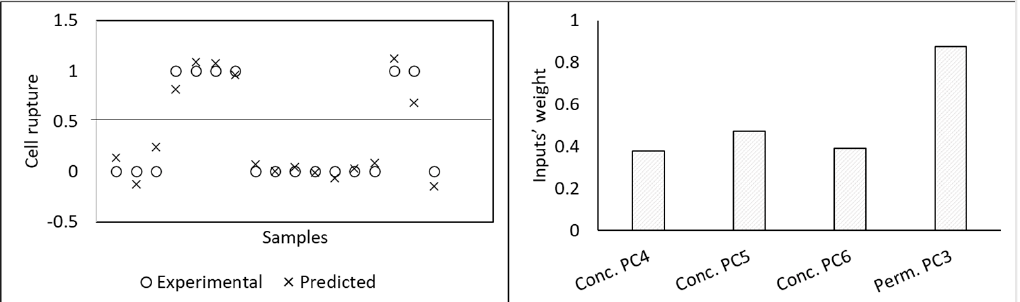
Figure 8. Results of PLS modelling for prediction of microalgal cell disruption during harvesting. Left: Experimental (circles) and predicted (x) values for cell rupture (unbroken (<0.5) and disrupted (>0.5) cells). Right: Weight of inputs selected (respectively, principal component (PC) 4, 5, and 6 from fluorescence spectra acquired in concentrate and PC 3 from fluorescence spectra acquired in permeate).